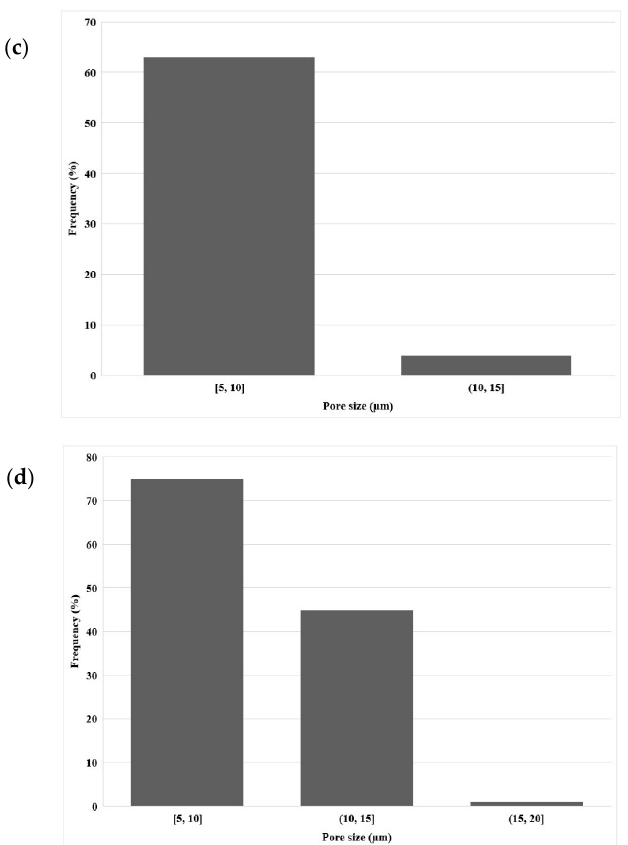
Figure 5. SEM images of: ( a ) LDPE membrane surface and ( b ) cross-section of the LDPE membrane after leaching (compression), ( c ) pore size distribution on the LDPE membrane surface, and ( d ) pore size distribution inside the LDPE membrane after leaching.